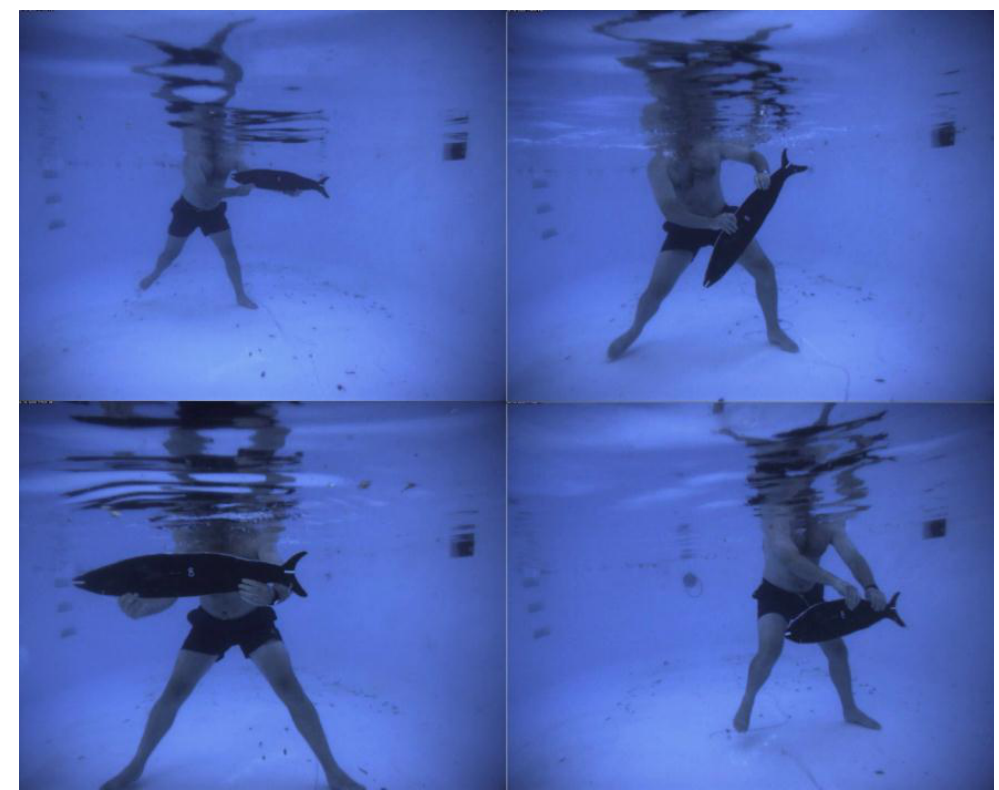
Figure 9. Example of a fish silhouette validation in a swimming pool (courtesy of Prof. E. S. Harvey).